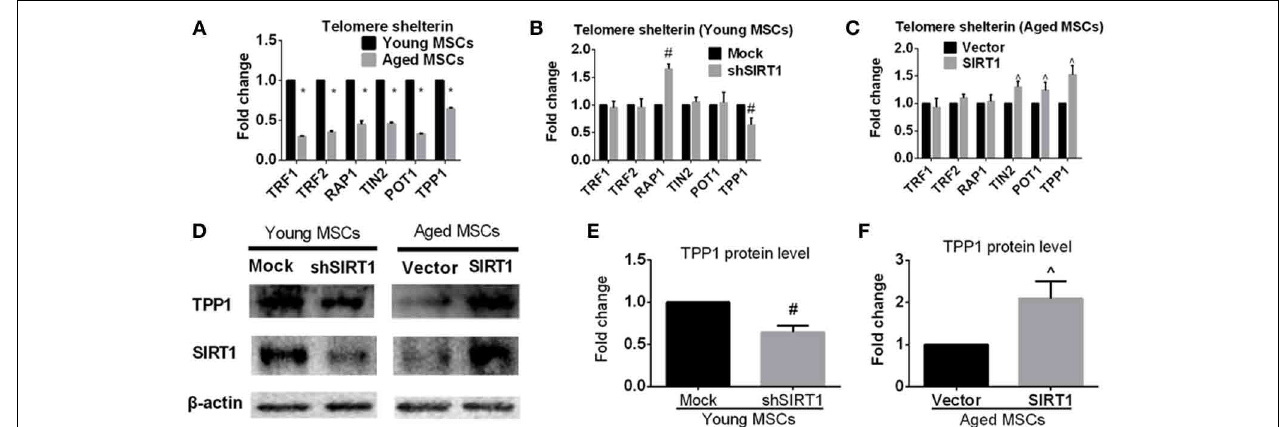
FIGURE 6 | SIRT1 positively modulates TPP1 expression in MSCs. (A) Age-related changes in mRNA levels of each telomere shelterin components including TRF1, TRF2, RAP1, TIN2, POT1, and TPP1 in MSCs was quantified. The mRNA expression levels were quantified when SIRT1 was manipulated in young (mock- and shSIRT1-) (B) and aged (vector- and SIRT1-) MSCs (C) . Representative immunoblot images